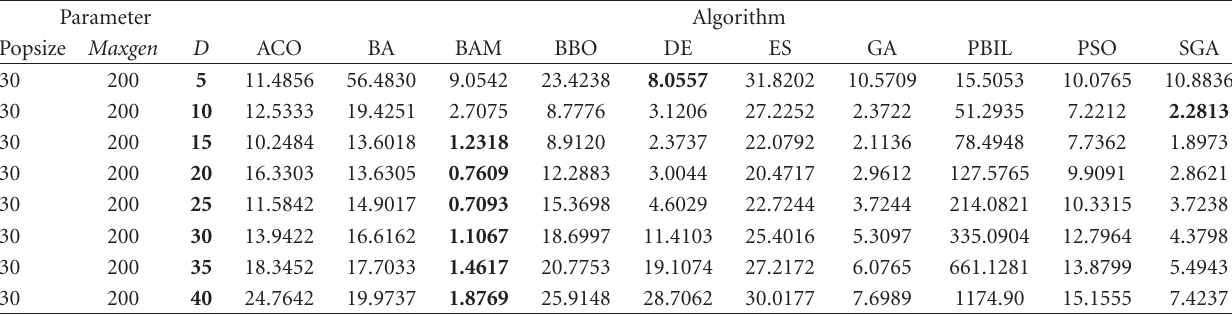
Table 8: Mean normalized optimization results on UCAV path planning problem on di ff erent D . The numbers shown are the minimum objective function values found by each algorithm, averaged over 100 Monte Carlo simulations.